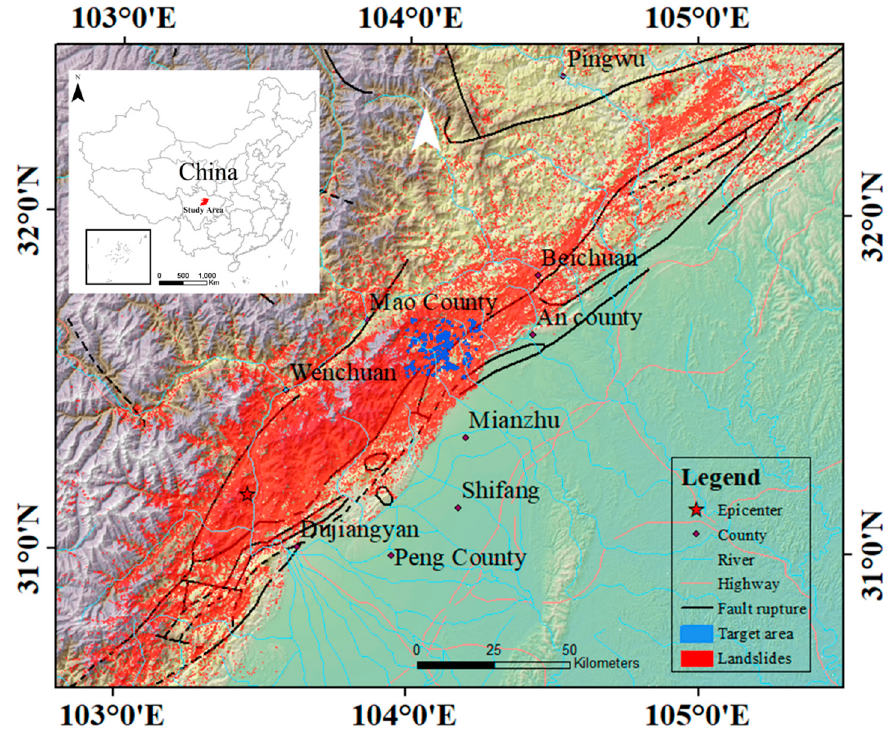
Figure 1. The study area with landslides caused by the 2008 Wenchuan earthquake and fault ruptures. Tests on the blue “target area” as examples of landslide detection.